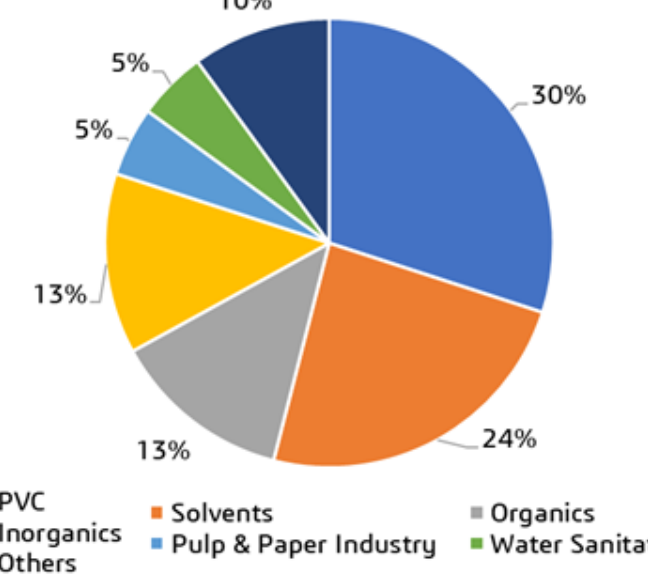
Figure 1. The uses of Cl 2 in various sectors [8]. The chlor-alkali industries convert its gaseous Cl 2 into hydrochloric acid (HCl), so- dium/calcium hypochlorite (NaOCl/Ca(OCl) 2 ), polyvinyl chloride (PVC), ammo- nium/zinc/calcium chloride (NH 4 Cl, ZnCl 2 /CaCl 2 ), chlorinated paraffin wax (CPW), and stable bleaching powder